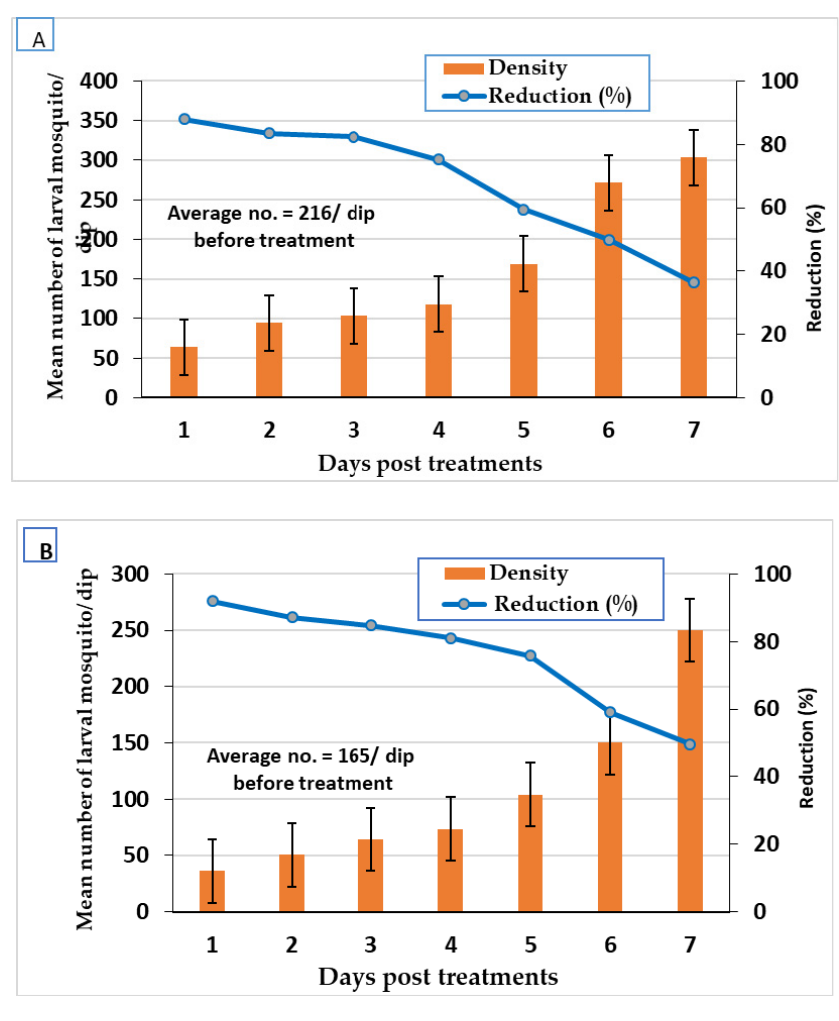
Figure 9. Field efficacy of green tea oil ( A ) and its Mg-LDH ( B ) treated at dose of LC 95 X2 (4201.5 and 2602.04 ppm, respectively) in larval breeding sites.